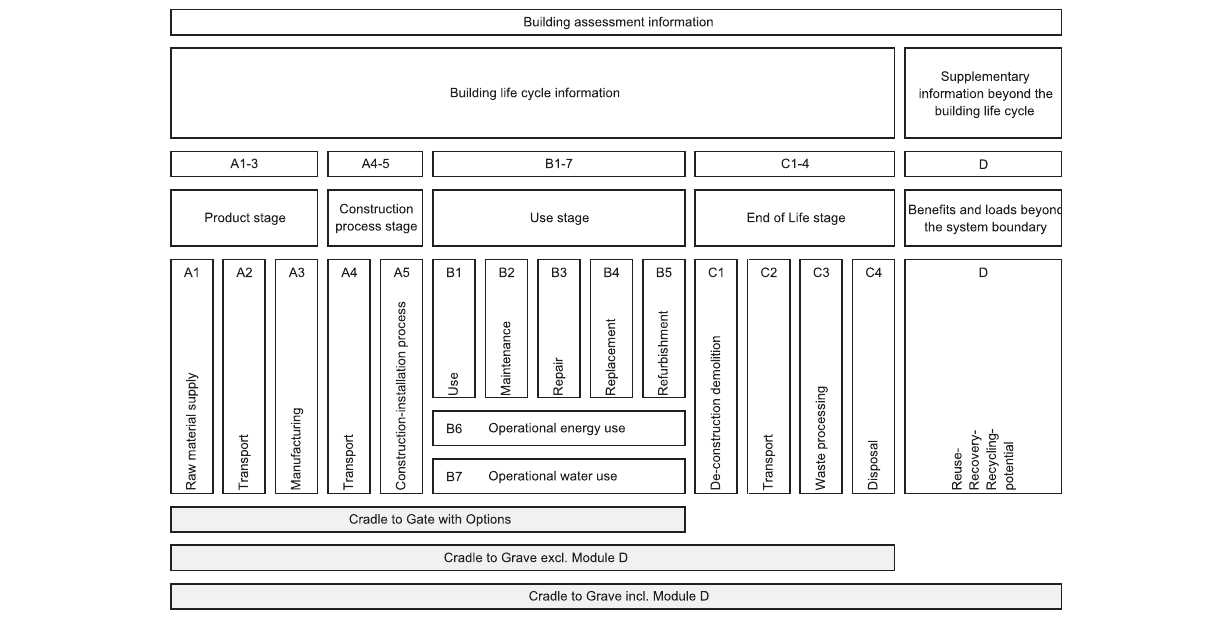
Frontiers in Built Environment |